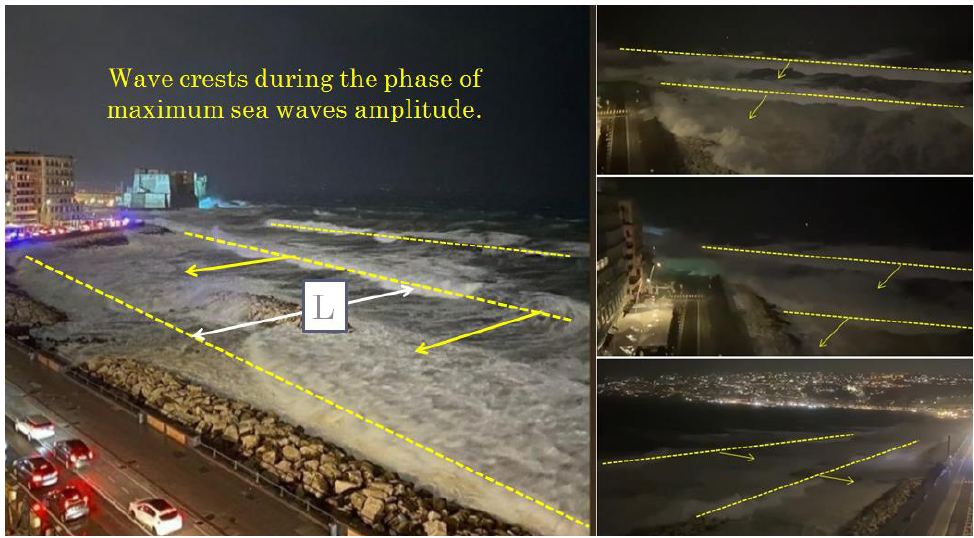
Figure 17. Photos taken from the buildings along Via Partenope, showing the waves scenario during the phase of maximum intensity of the swell.